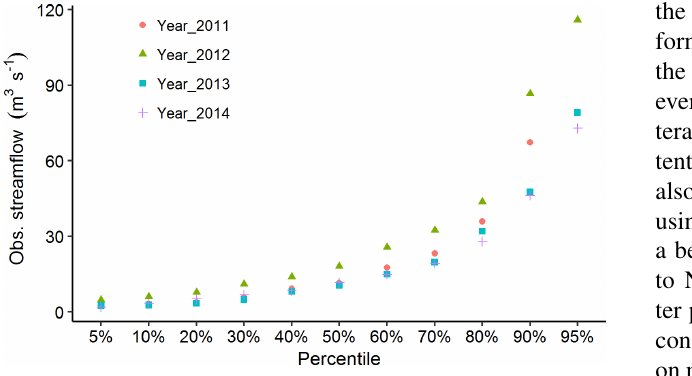
Figure 9. Comparison of the percentile of observed streamflow val- ues for the calibration period (Year_2011) and validation periods (Year_2012, Year_2013, and